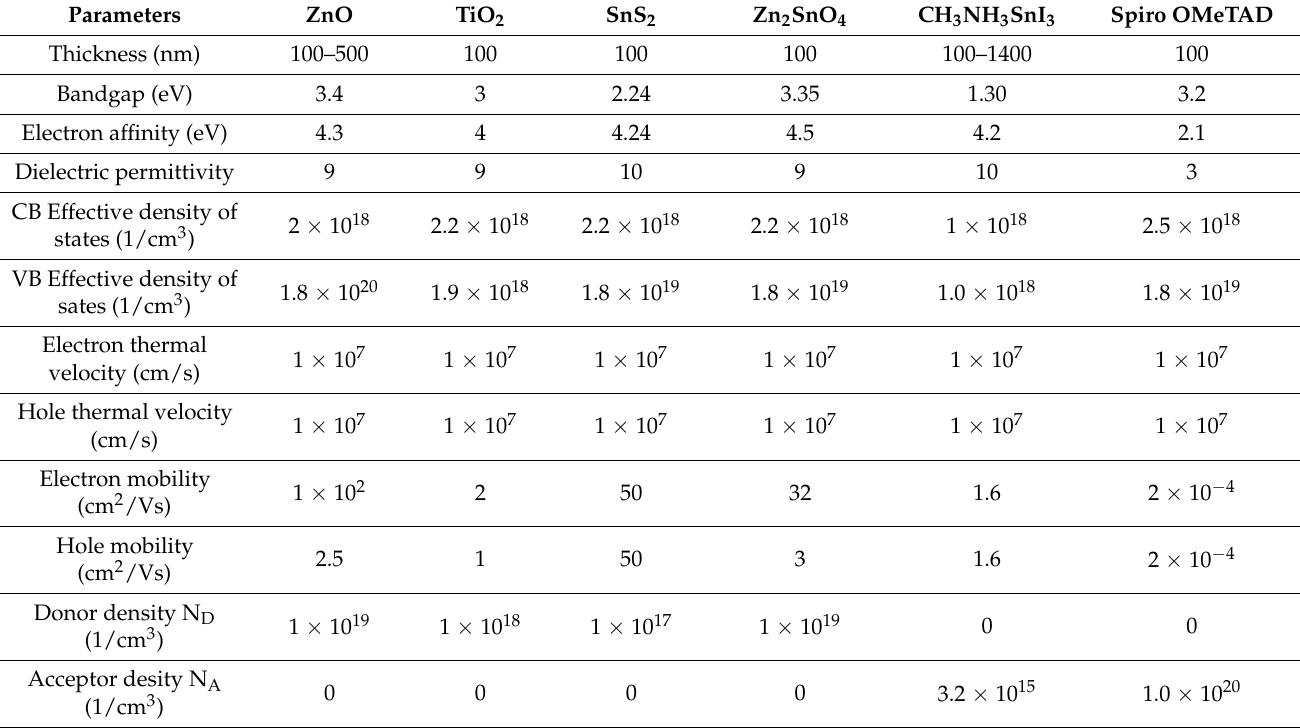
Table 1. Parameters used to run the simulation of Tin (Sn) based perovskite solar cells.